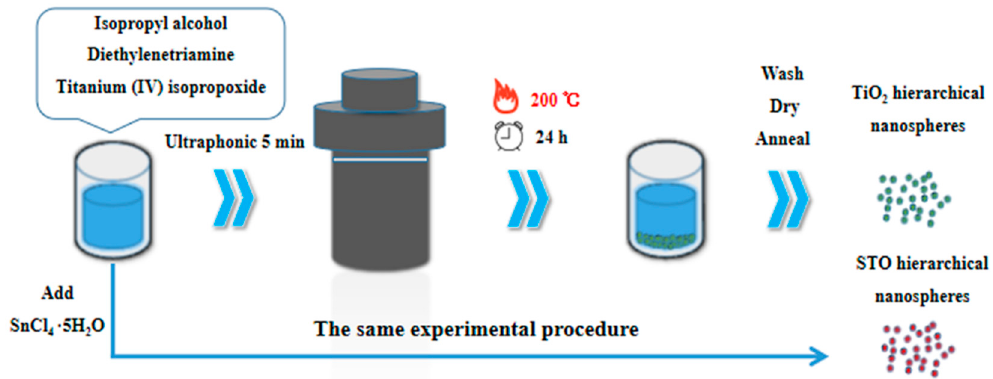
Figure 1. Schematic illustration of experimental procedure.